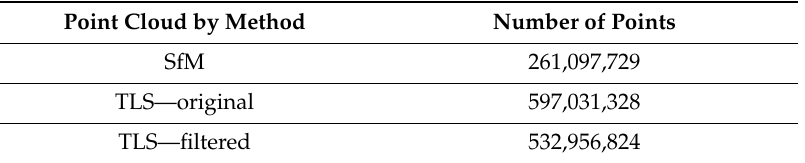
Table 3. Numbers of points in the acquired point